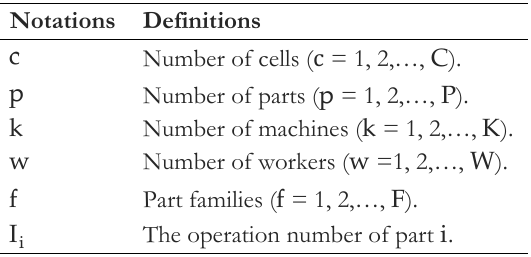
Table 1. Definitions of indices.